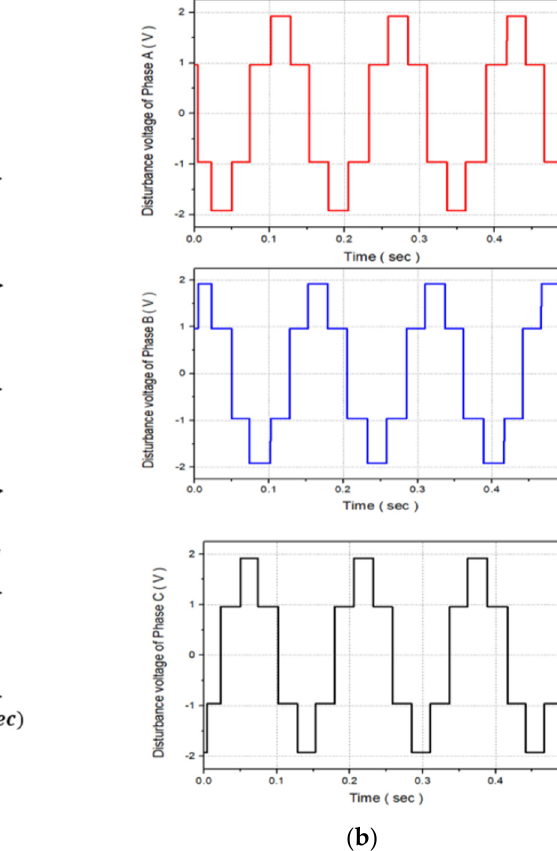
Figure 9. Distorted voltage due to dead time appearing on the d − q coordinates waveform V r , and the motor rotor angle waveform θ r . q _ dead